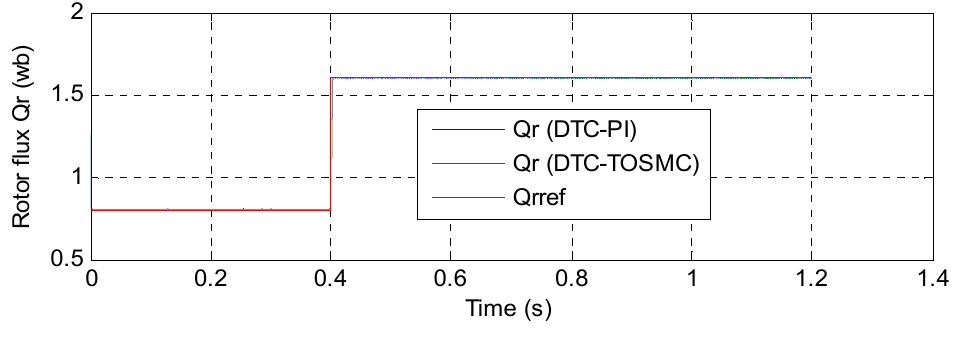
Figure 9. Rotor flux.